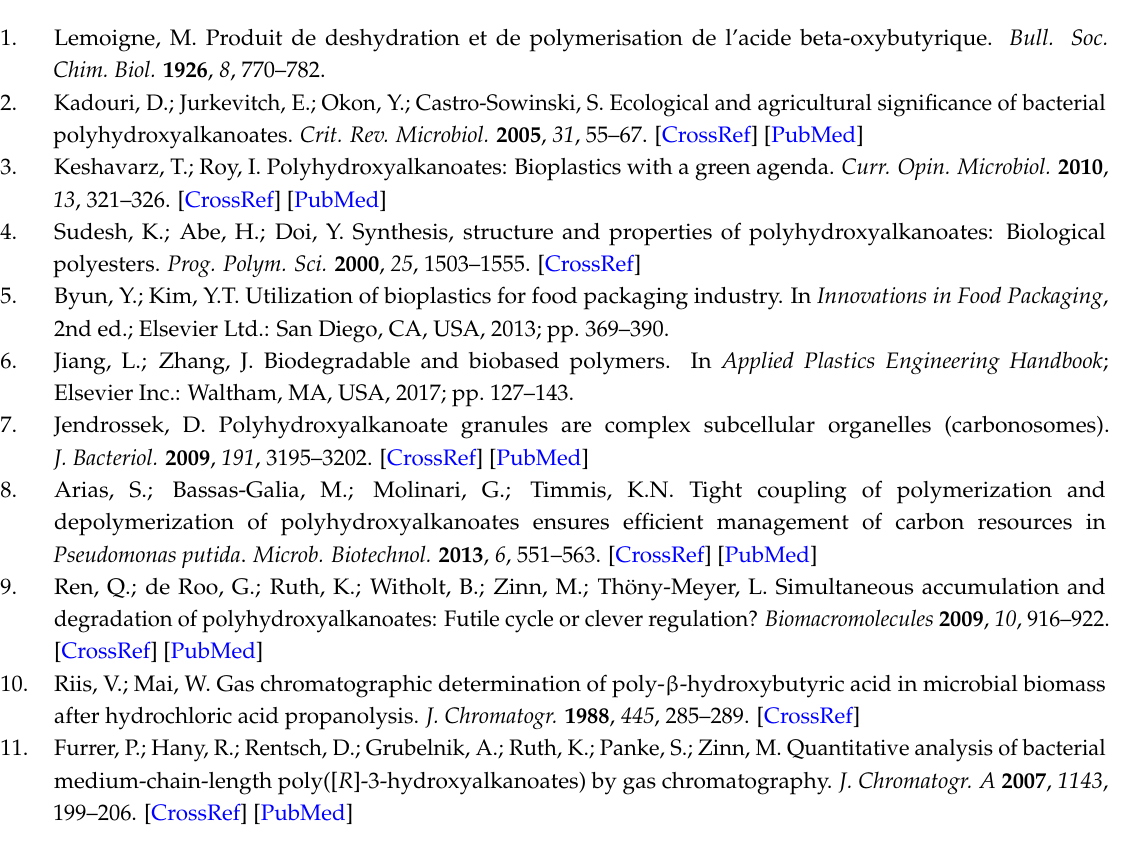
Figure S1: Fluorescence scatter plots and histograms from flow cytometry measurements during the PHA polymerization-depolymerization